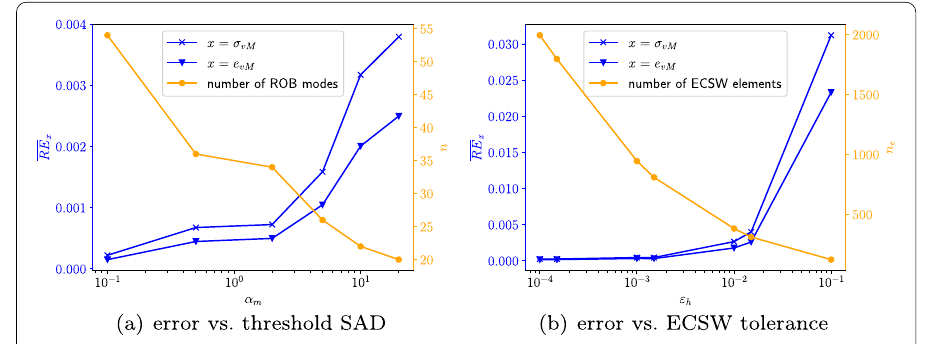
Fig. 13 Mean relative l2-error for DROM over varying threshold SAD α m (left plot) and mean relative l2-error for DHROM over varying ECSW tolerance ε h (right plot) are depicted in blue (curves and y-axes). Curves and y-axes in orange depict the corresponding number of ROB modes n (left) and number of selected ECSW elements n e (right)